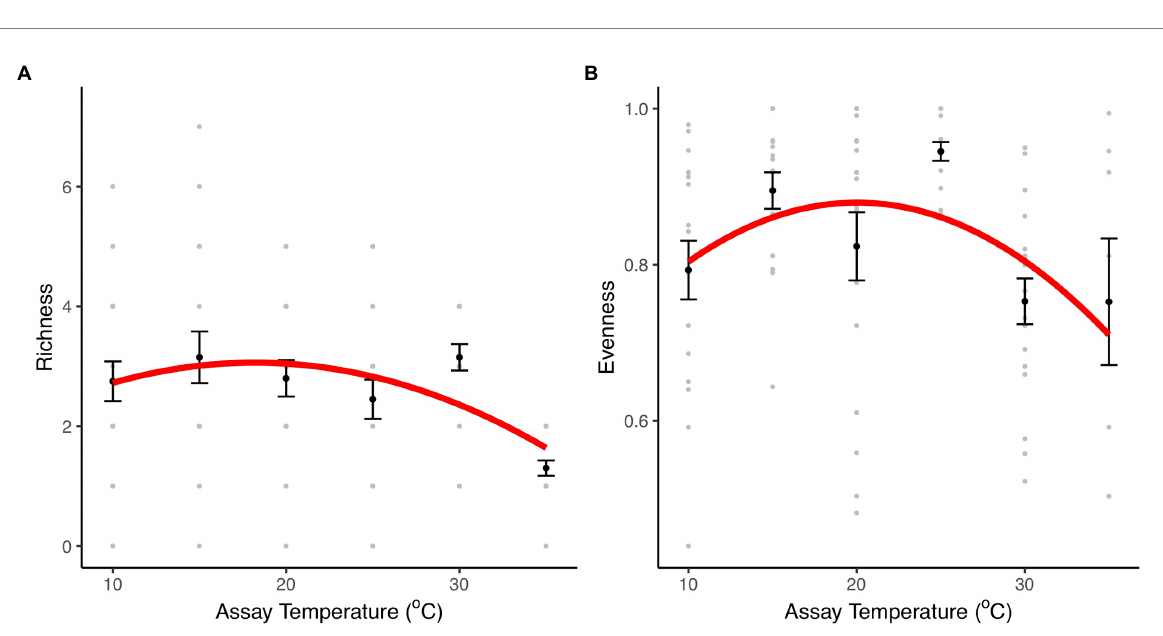
within communities exposed at intermediate temperatures (Figure 4A; Supplementary Figure S2). Pseudomonas sp. was more persistent within communities at 20 ° C and Aeromonas